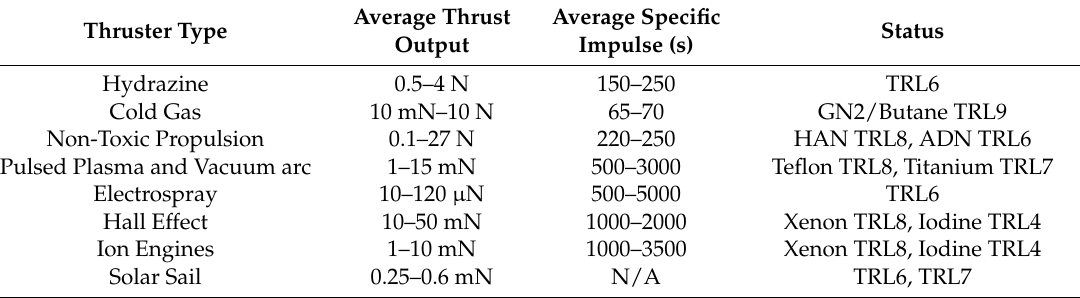
Table 5. Propulsion Systems for Small Spacecraft [23].